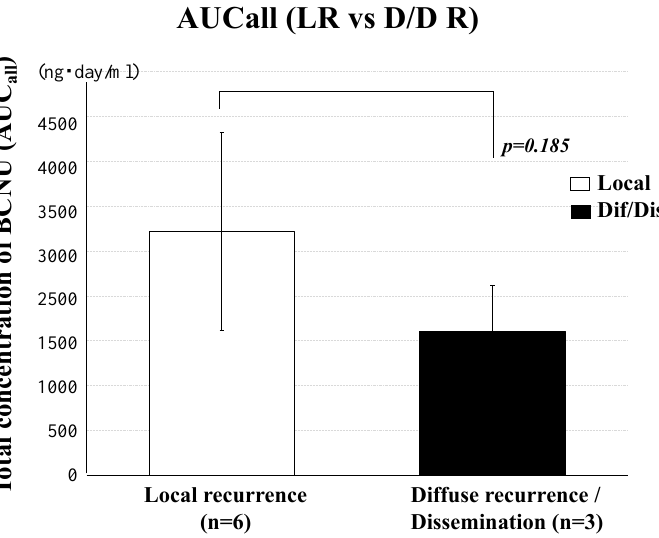
Figure 5. Patterns of tumor recurrence following treatment with BCNU wafers and the effects of AUC all on the tumor recurrence patterns. ( a ) Tumor growth patterns at the time of tumor recurrence were classified into three types on MRI according to continuity with the areas around the resection cavity (arrows show the sites of tumor recurrence). ( b ) Illustration showing the recurrence patterns of tumors. These included tumors recurring from the edge of the tumor resection cavity (local recurrence), diffuse infiltration to a distant area (diffuse/distant invasion), and meningeal and intraventricular dissemination (dissemination). The two latter patterns were non-local recurrence. ( c ) Effects of the total concentration (AUC all ) of BCNU on the recurrence pattern in GBM. No significant difference was present in AUC all between local recurrence and non-local recurrence ( p = 0.185). A white color bar graph shows AUC all of local recurrence and a black color bar graph shows that of non-local recurrence. Error bars represent standard deviation.